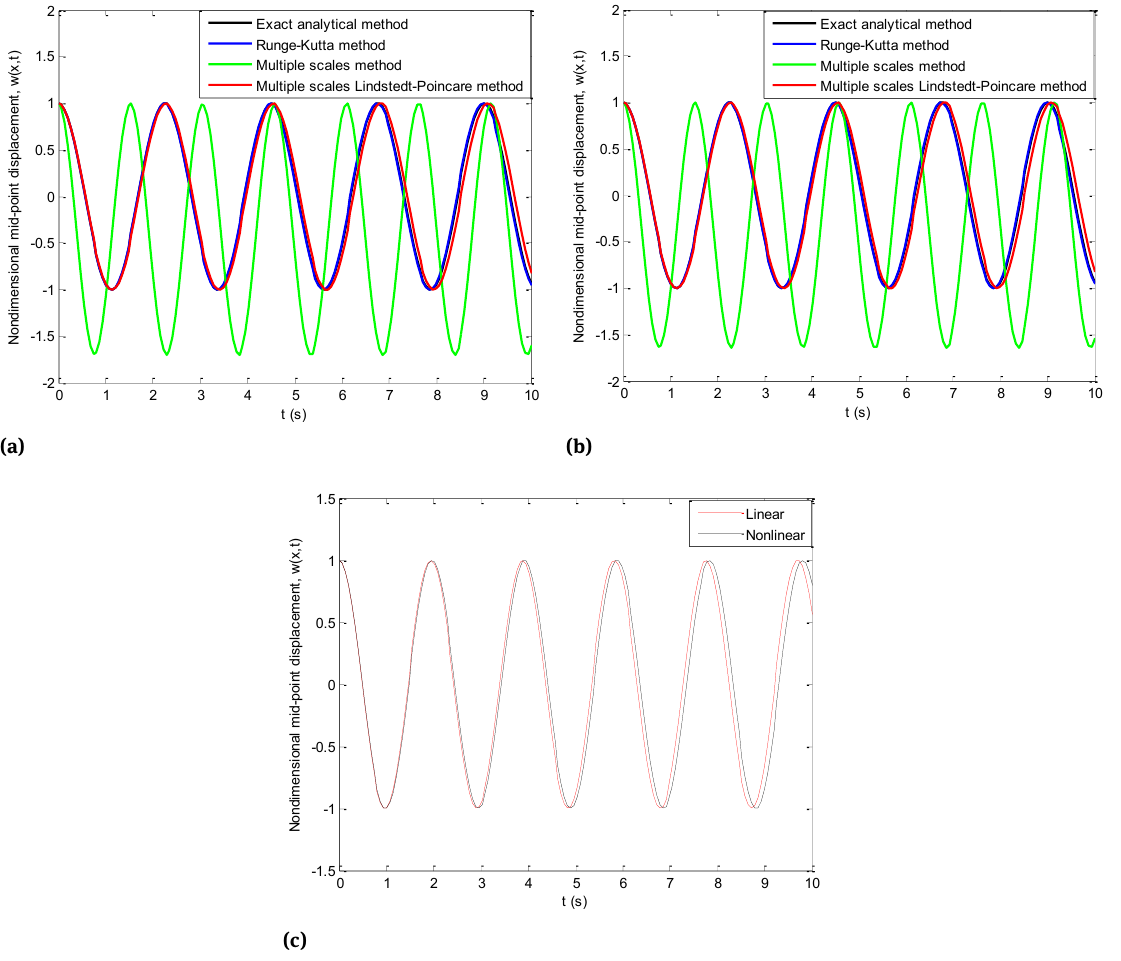
Figure 3: (a) Comparison of results when ε = 10 , a 0 = ˜ λ 2 = ˜ λ 3 = 1 , ω 0 = π (b) Comparison of results when ε = a 0 = 1 , ˜ λ 2 = 10 , ˜ λ 3 = 100 , ω 0 = π (c) Comparison of results and effect of nonlinearity on the dynamic behaviour